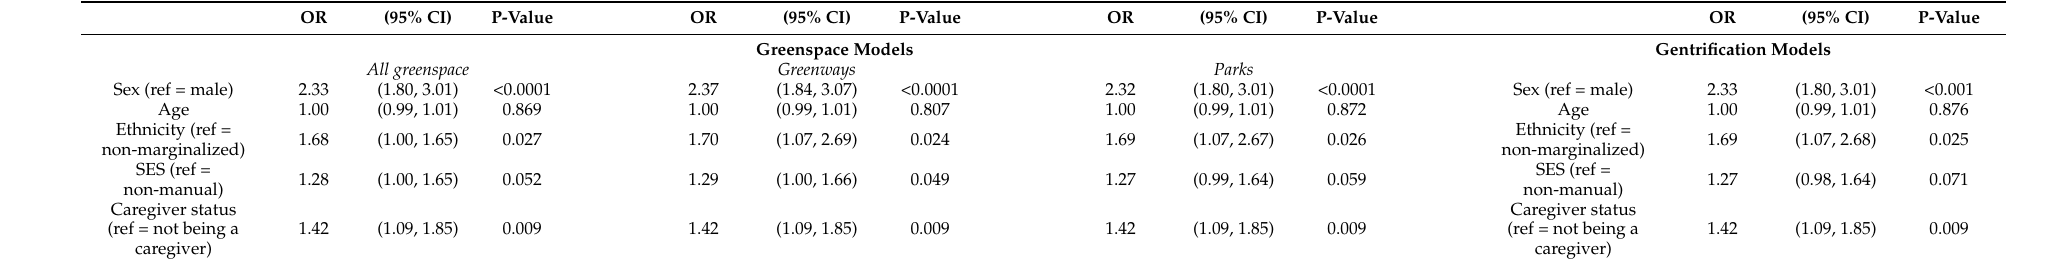
Table 2. Logistic regression models (weight-adjusted and spatial clustering) adjusted for sociodemographic variables (sex, age, ethnicity, socioeconomic status and caregiver status) ( n = 2367 in models involving mental health; n = 2450 in models involving